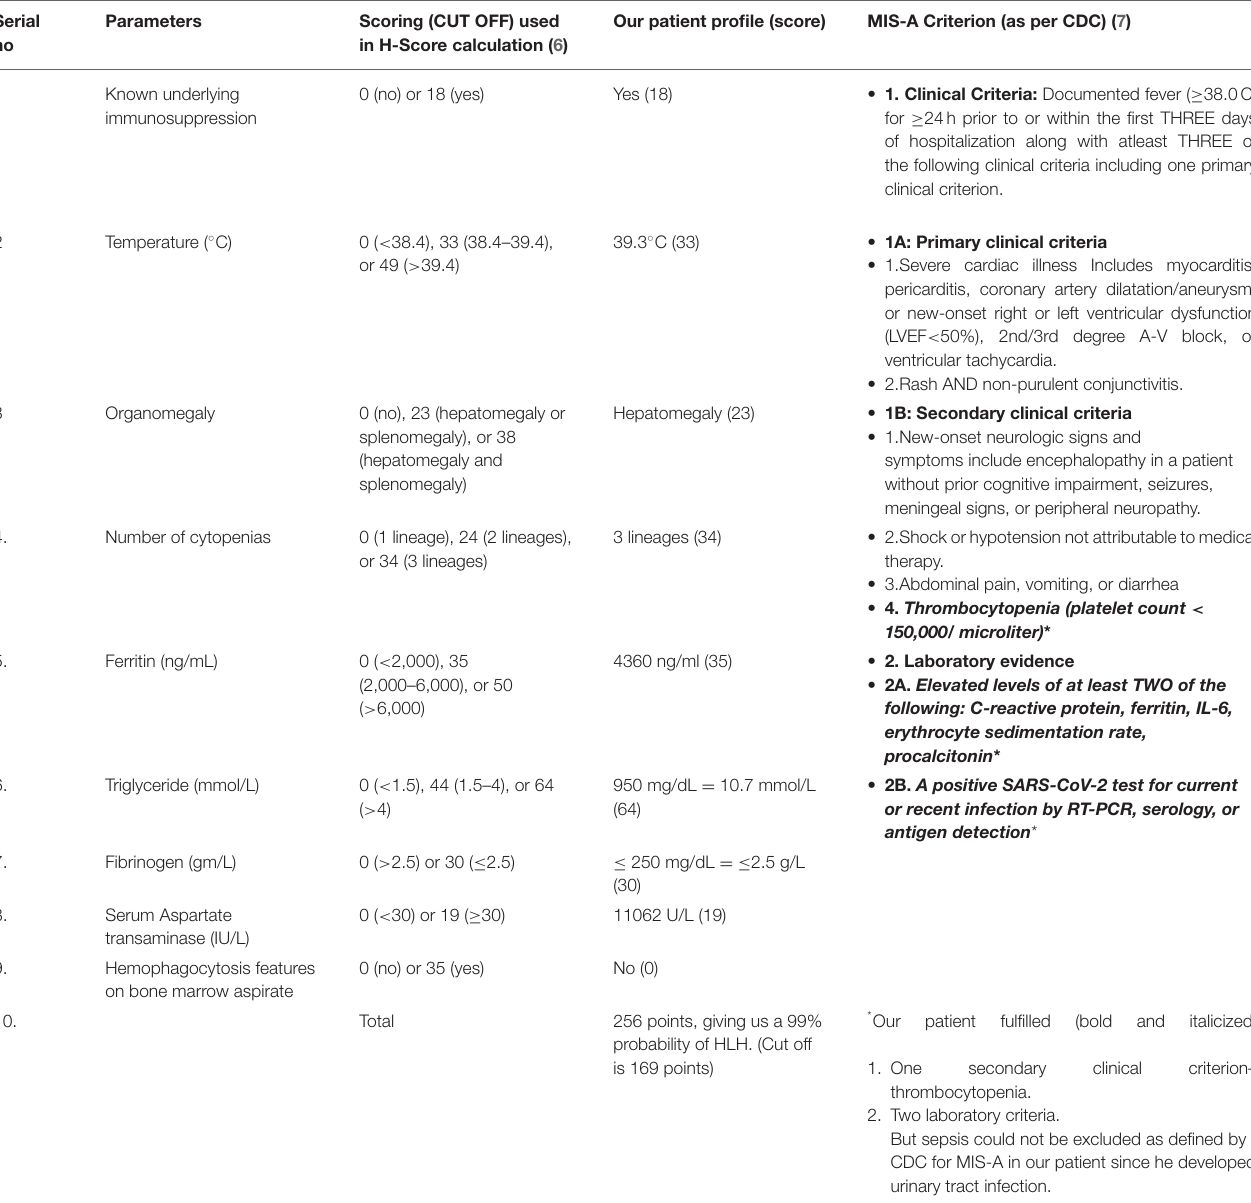
TABLE 2A | Calculation of H- Score (6) and Center for Disease Control (CDC) Multisystem Inflammatory Syndrome-Adults (MIS-A) criteria (7). H-Score calculation as per the criteria by Fardet et al. (6) An H-Score of 256 was found in our patient, giving us a 99% probability of hemophagocytic lymphohistiocytosis (HLH). Serial Parameters Scoring (CUT OFF) used Our patient profile (score) MIS-A Criterion (as per CDC) no in H-Score calculation (6)